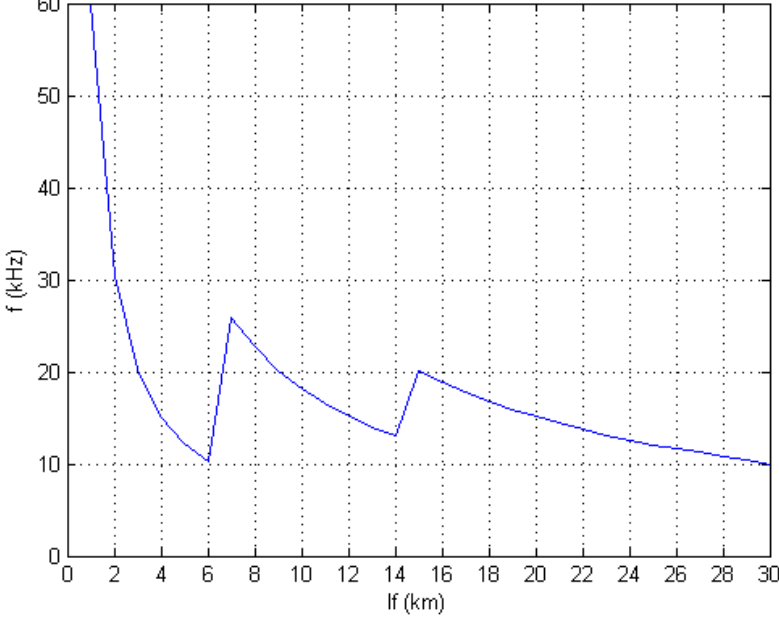
versus fault distance, l res